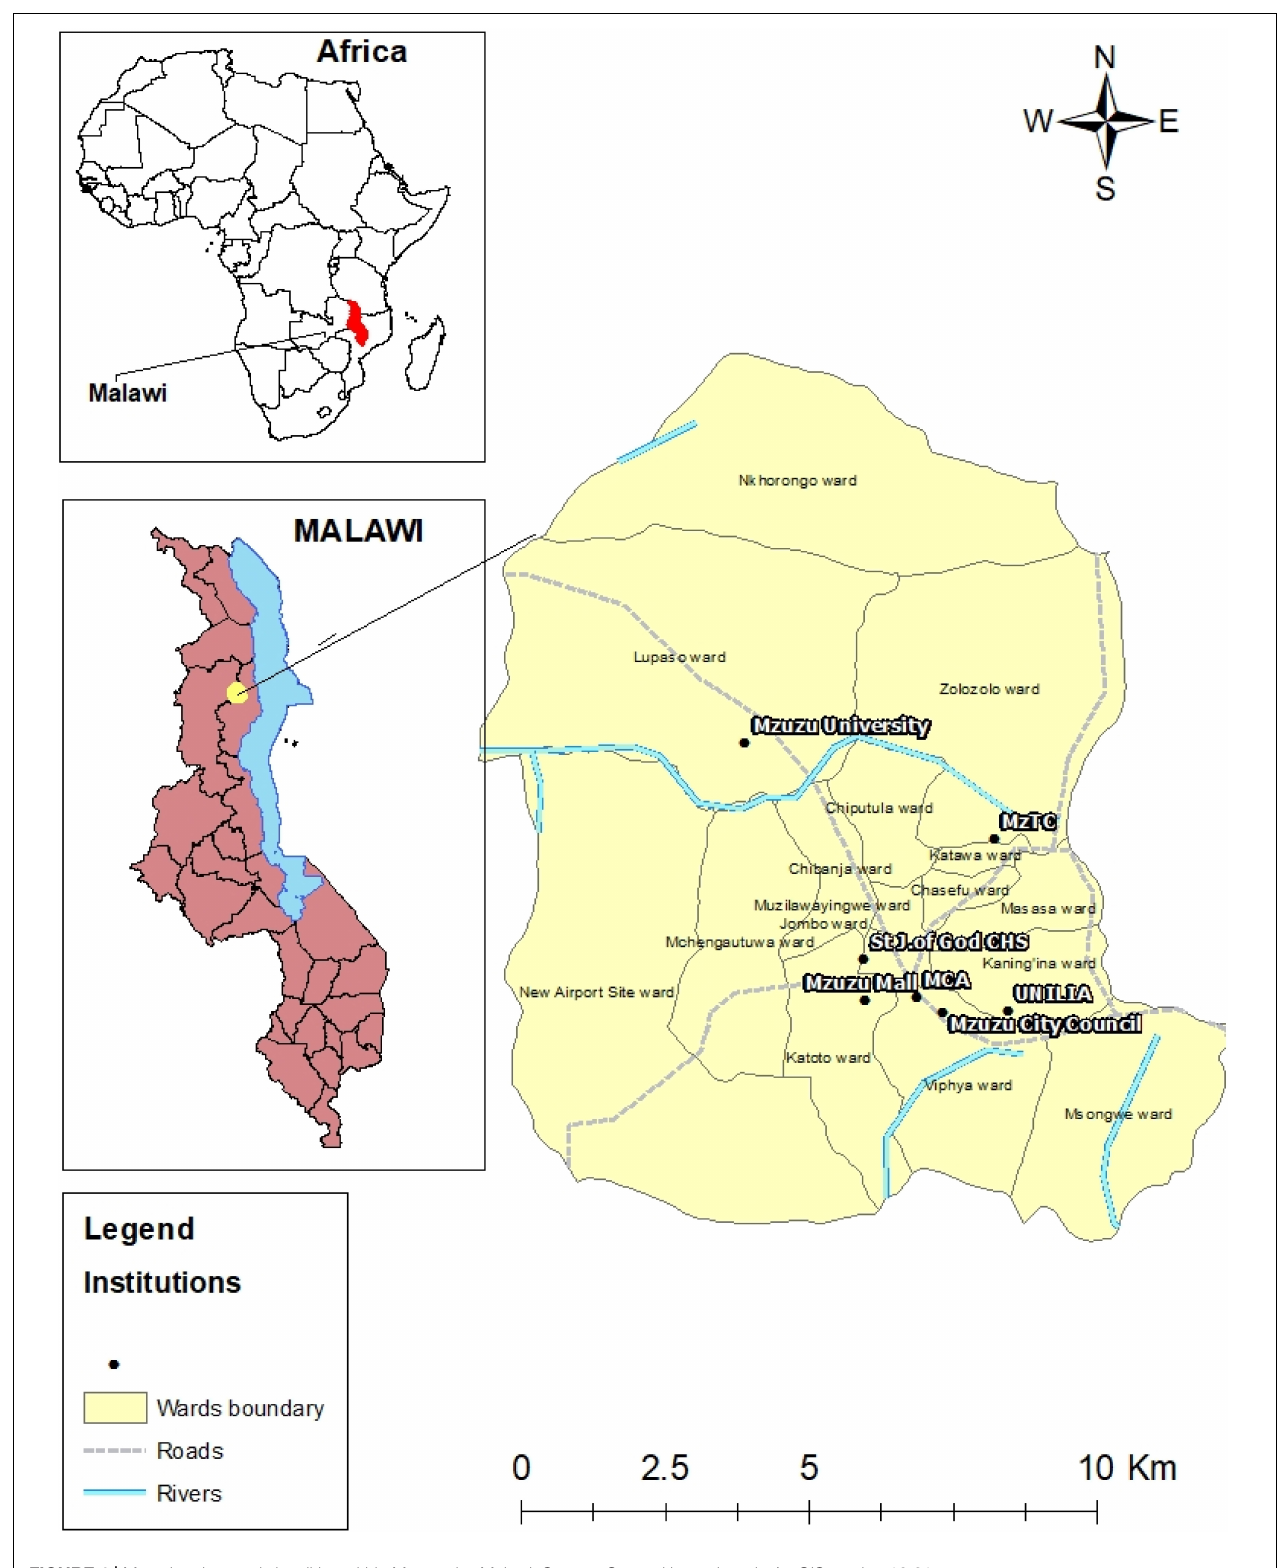
FIGURE 1 | Map showing study localities within Mzuzu city, Malawi. Source: Created by authors in ArcGIS version 10.61.